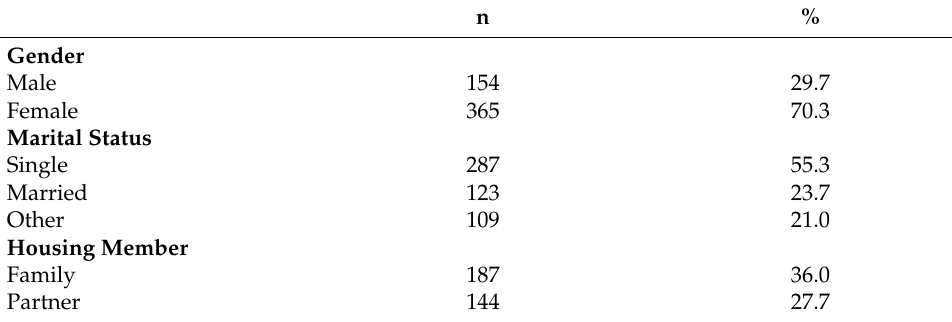
Table 1. Characterization of evaluated graduate